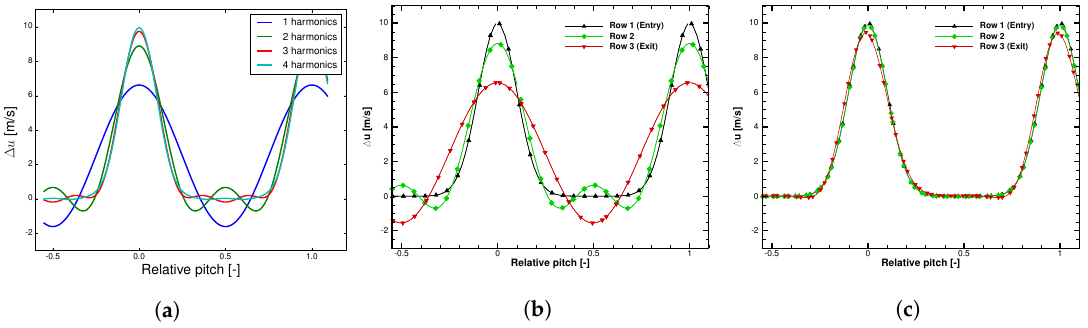
Figure 4. Density distribution over circumferential coordinate at inlet, outlet, and third interface. analytic solution ( a ); numerical solutions with HB configuration 1 ( b ); and HB configuration 2 ( c ). Table 1. Harmonic set configurations for the numerical experiment of jet propagation through duct